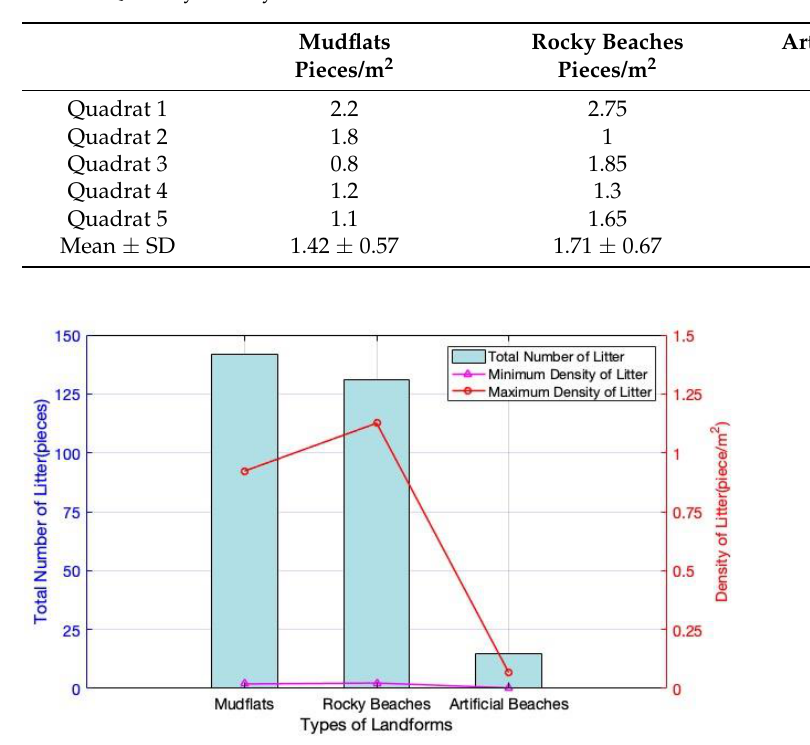
Table 3. Quantity density of litter in each district.